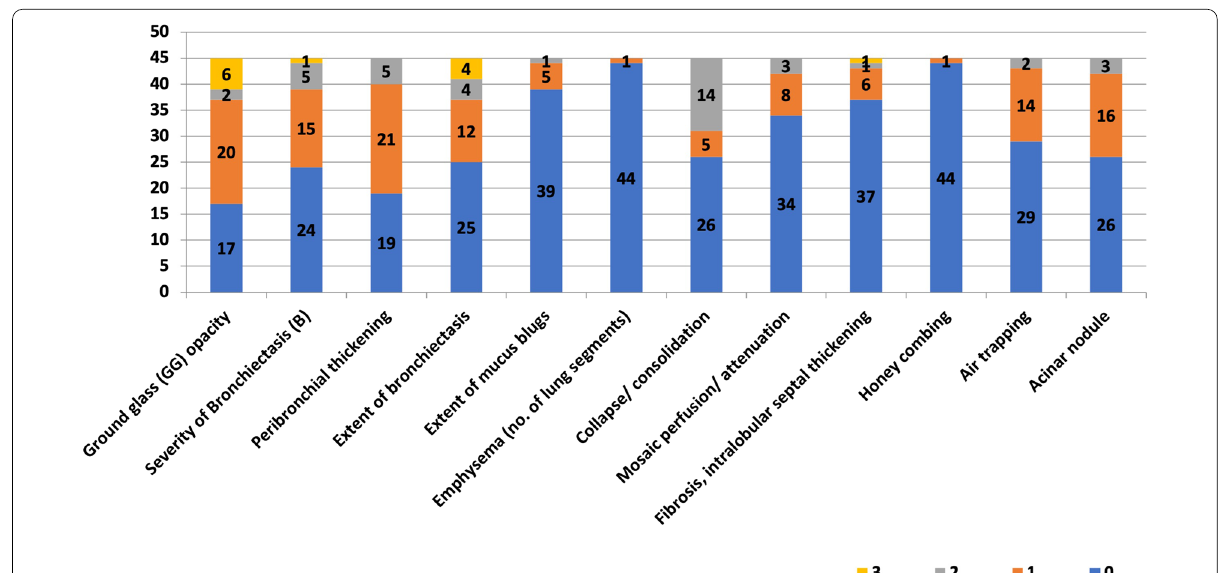
Fig. 3 Column chart showing the distribution of the components of the Bhalla scores for chest CT among the included children